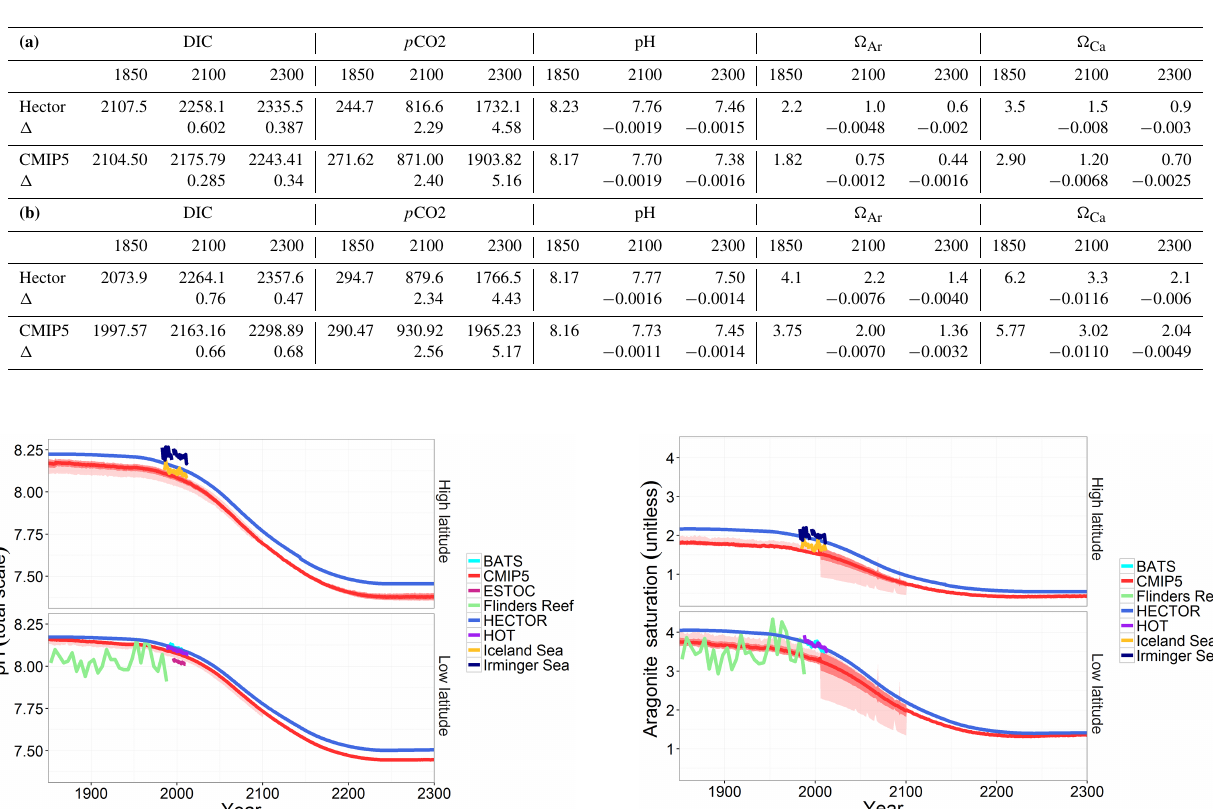
Table 5. Absolute values and rates of change per year ( (cid:49)) for the (a) high- and (b) low-latitude surface ocean from 1850 to 2100 and 2101 to 2300 under RCP 8.5 for DIC (µmolkg − 1 ) , p CO 2 (µatm), pH (total scale, unitless), (cid:127) Ar (unitless), and (cid:127) Ca (unitless).